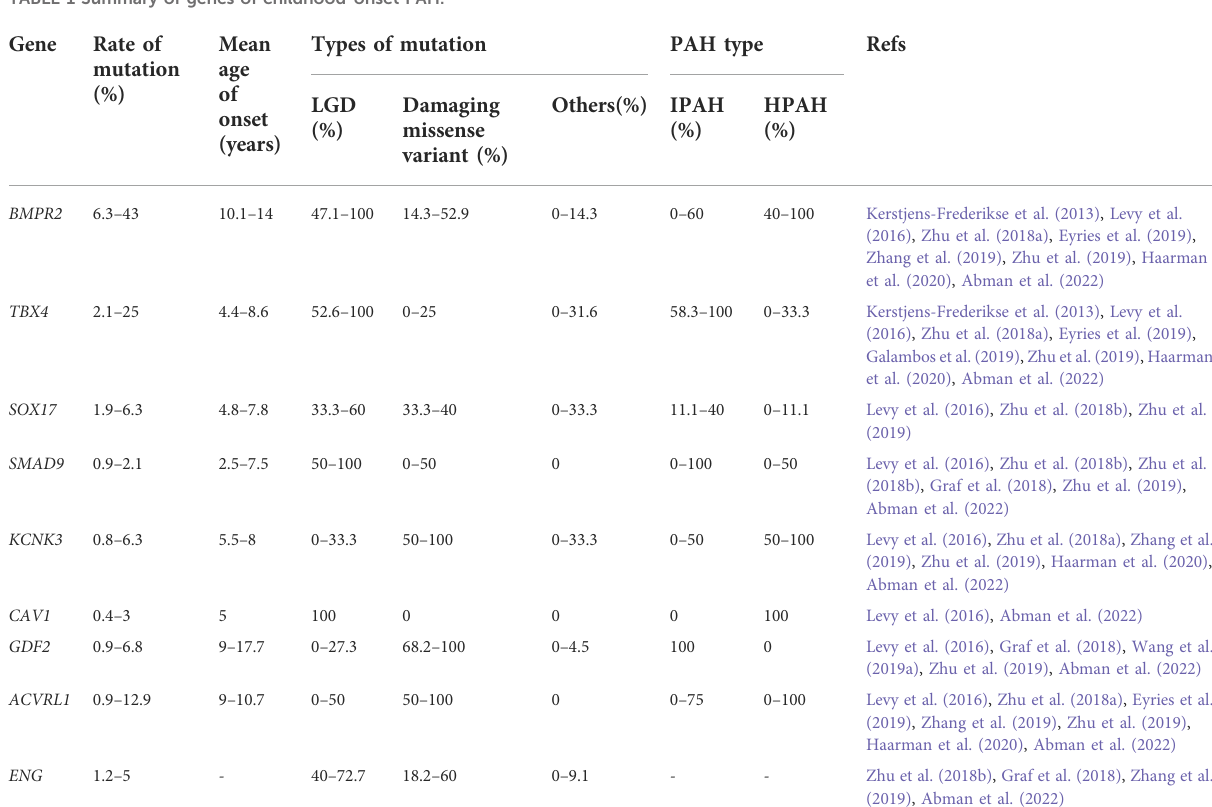
TABLE 1 Summary of genes of childhood-onset